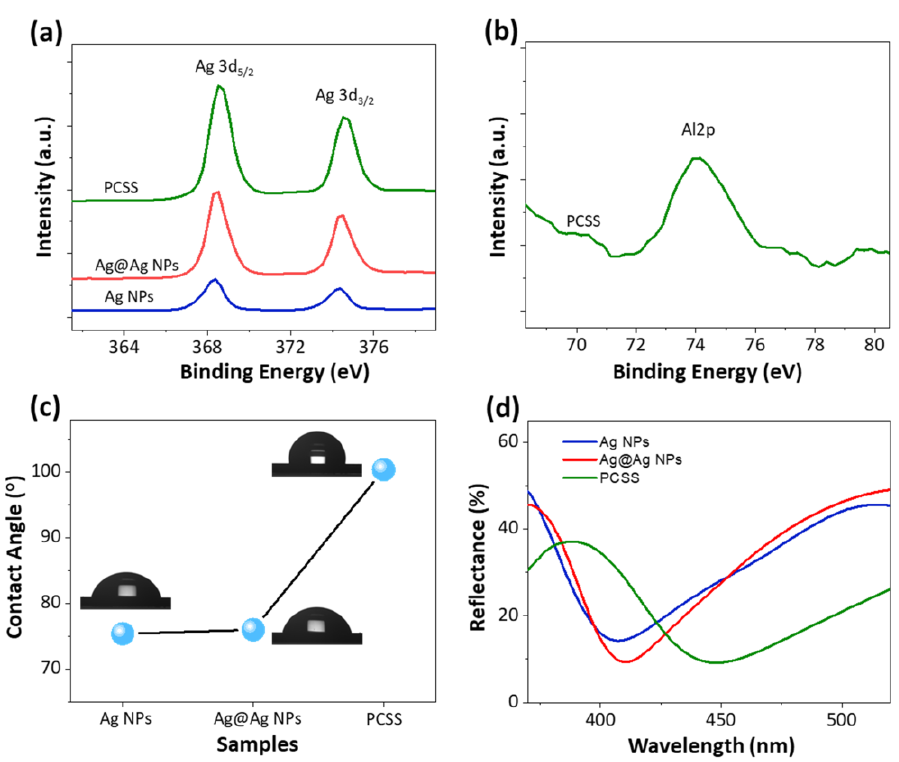
Figure 2. Surface compositional, wettability, and optical characteristics of three different plasmonic nanostructures: Ag NP template, Ag@Ag NP, and PCSS. XPS spectra of ( a ) Ag and ( b ) Al 2p of corresponding nanostructures. ( c ) Water contact angle (WCA) and ( d ) UV – Vis – NIR reflectance spectra of plasmonic nanostructures.